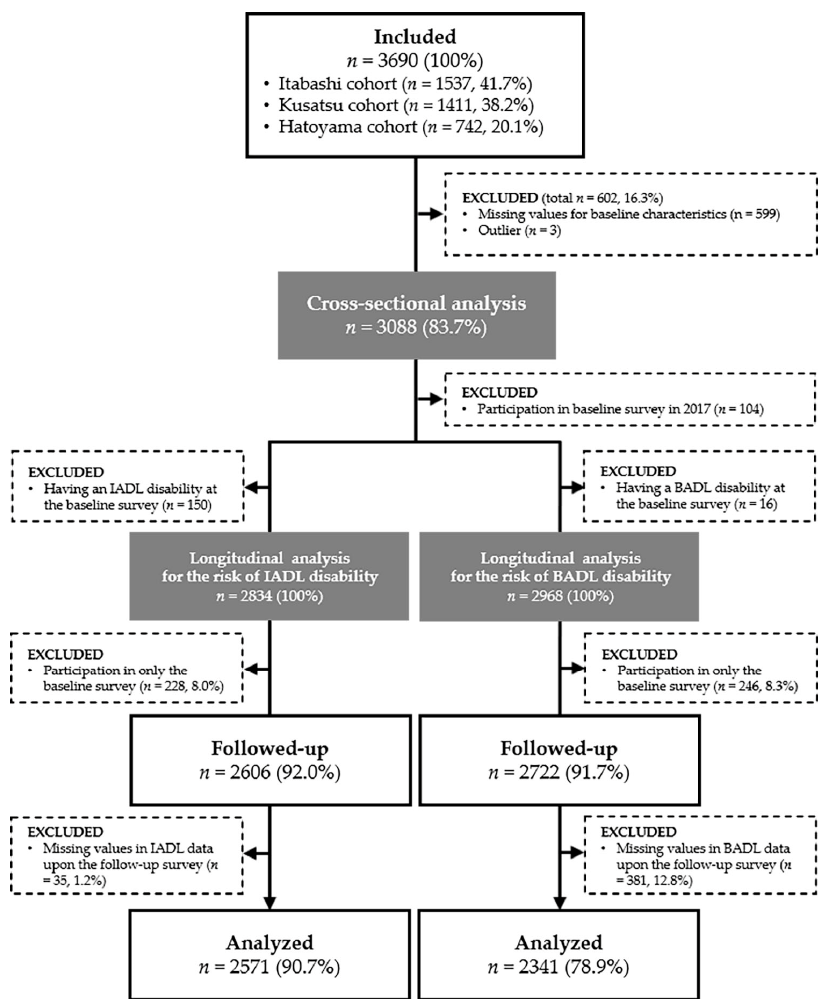
Figure 1. Flowchart of study participants. BADL, basic activities of daily living; IADL, instrumental activities of daily living.